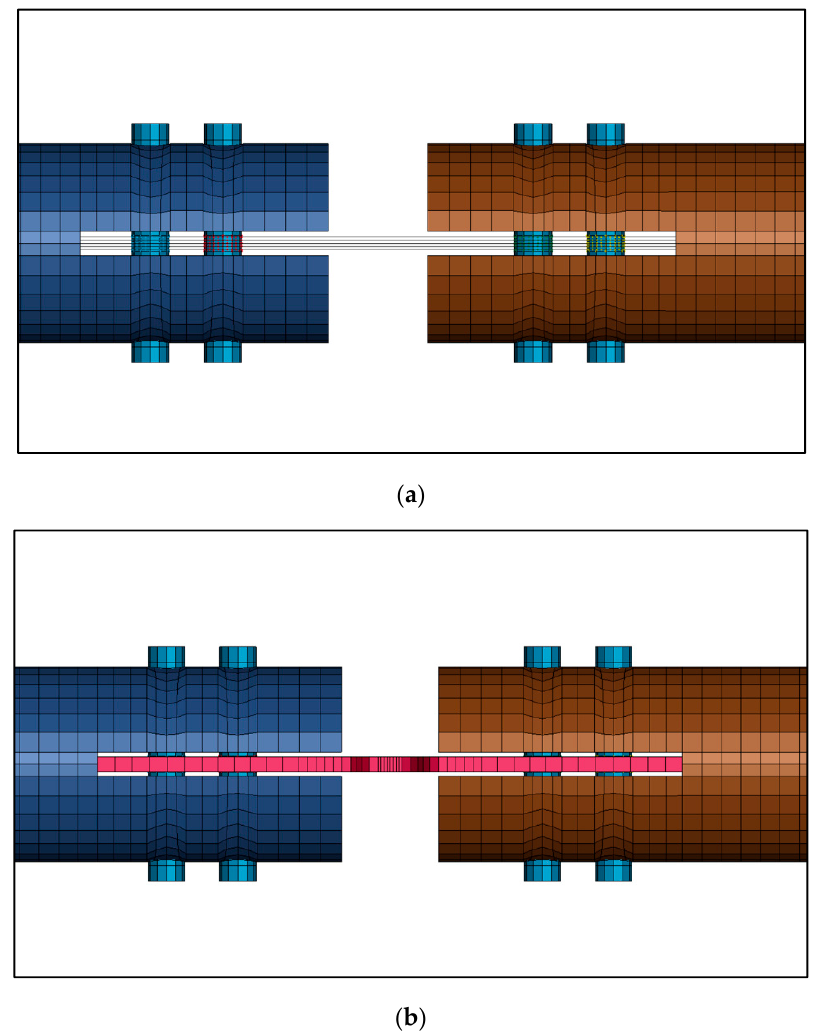
Figure 3. Close-up look at the split Hopkinson tensile bar (SHTB) grip, bolt, and specimen with the configuration of ( a ) stacked specimens, ( b ) single sheet element with similar total thickness with the stacked simulation with thickness feature enabled to show the thickness of the shell.